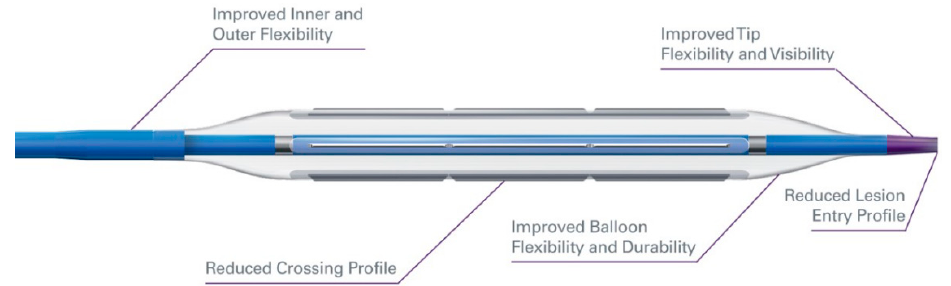
Figure 1. Wolverine Cutting Balloon. Courtesy Boston Scientific Corporation.